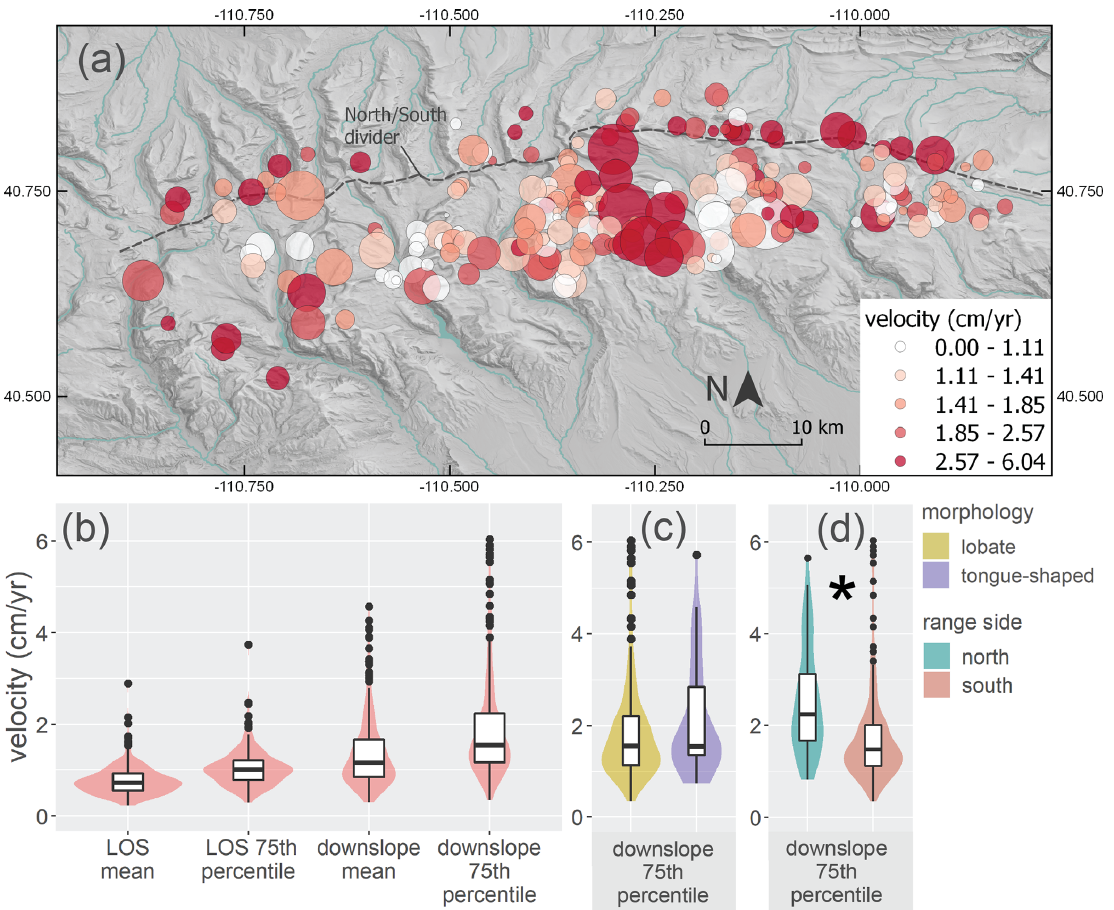
Figure 7. Average annual downslope velocities of active Uinta rock glaciers from 2016 to 2019. (a) Map showing rock glacier area and velocity. Each rock glacier is represented by a circle. Size of circle represents relative rock glacier area, and color represents absolute value of rock glacier 75th percentile downslope velocity. Note fewer, smaller, slower rock glaciers in the North Uintas. (b) Violin plots show absolute value of mean and 75th percentile LOS and downslope velocities for all rock glaciers. (c) Violin plots show 75th percentile downslope velocities for rock glaciers classified by morphology. (d) Violin plots show 75th percentile downslope velocities for rock glaciers classified by which side of the Uinta Mountains they are on. Asterisks denote significant differences, and n =